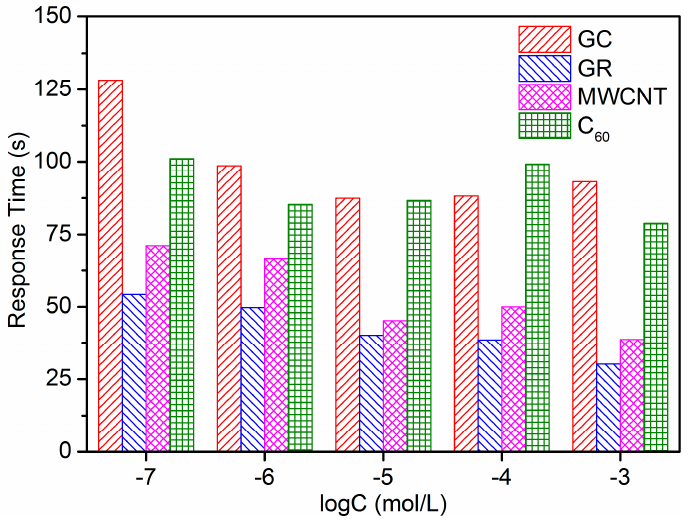
Figure 6. Potentiometric response time of different Pb 2+ ‐ ISEs in the range of Nernstian response.